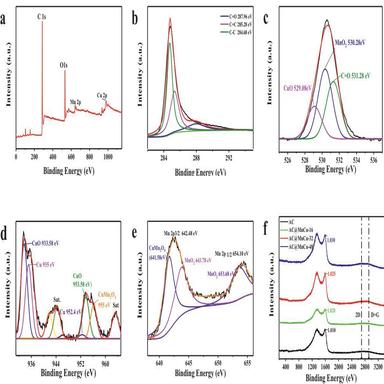
(a) Full-scan XPS survey and high-resolution XPS spectra for (b) C 1s, (c) O 1s, (d) Cu 2p and (e) Mn 2p of AC@MnCu-32; (f) Raman spectra of four carbon materials.